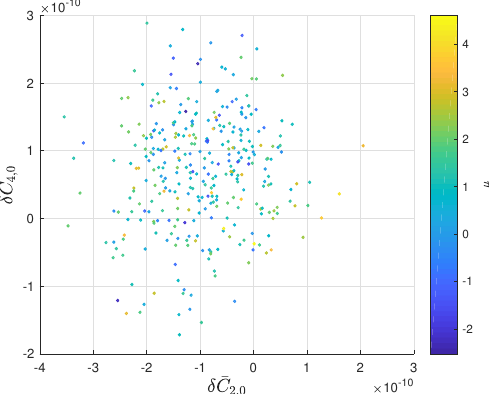
Figure 5. The estimated relativistic Lense-Thirring parameter µ as a function of the corrections simultaneously estimated for the quadrupole and octupole coefficients. The slightly negative correlation with the corrections to the octupole coefficient is however evident from the distribution of the values assumed by µ